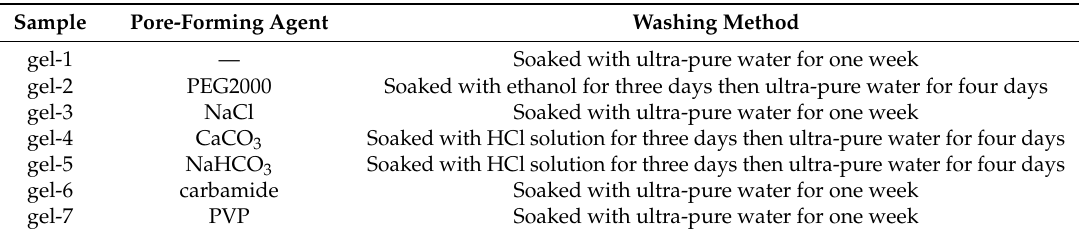
Table 1. Preparation conditions of hydrogels with different pore-forming